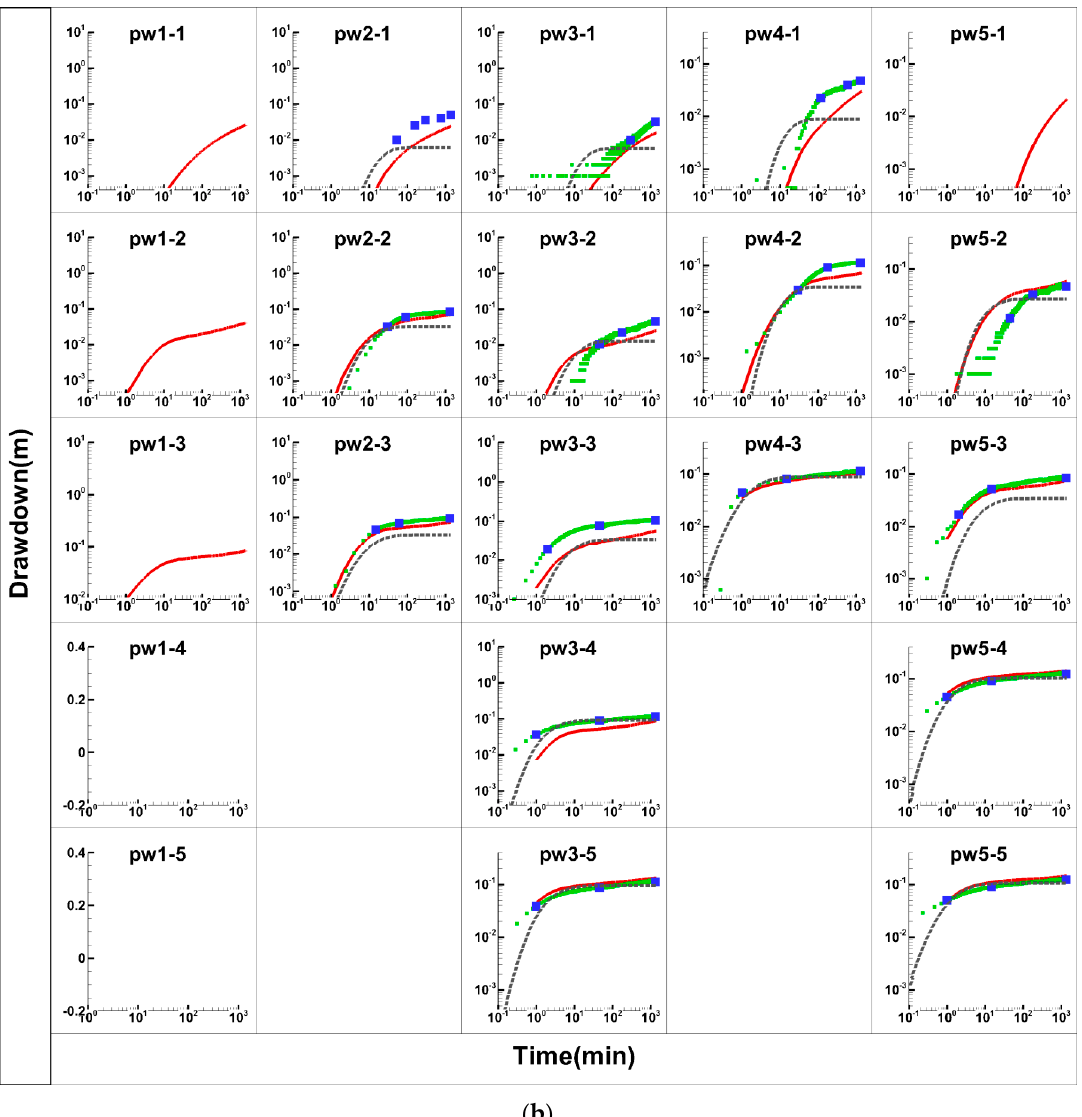
Figure 6. Observed drawdown in ( a ) CMT and ( b ) PW ports during the pumping test at PW1–5. The blue dots are manual measured data with a water level tape, the green dots are the observed drawdown data, the red lines represent simulated drawdown data using 14 tests for THT analysis, and the black dashed lines are simulated drawdown data by Berg and Illman [18].